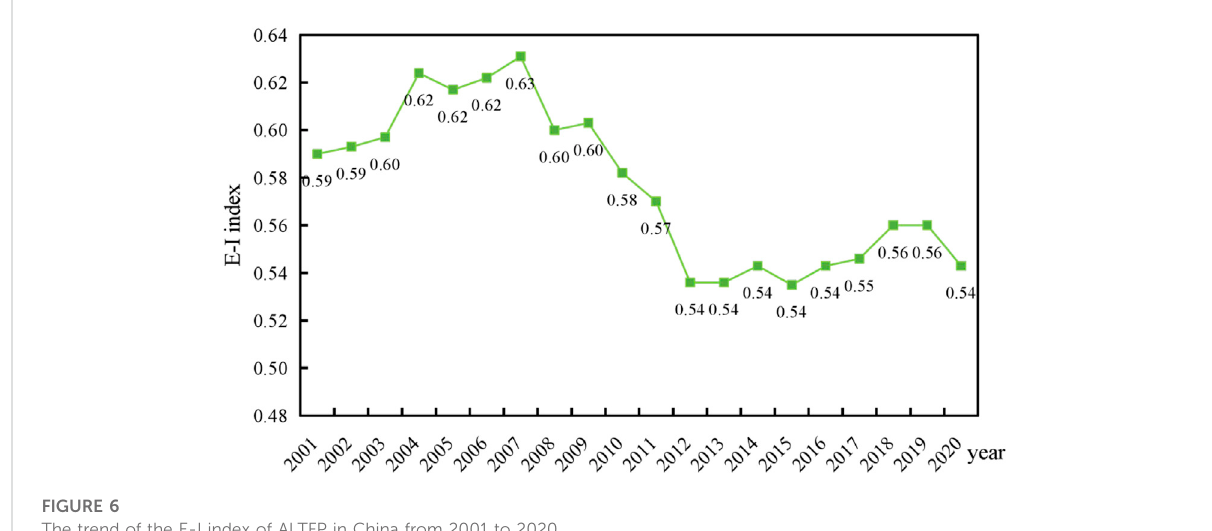
FIGURE 6 The trend of the E-I index of ALTFP in China from 2001 to 2020.